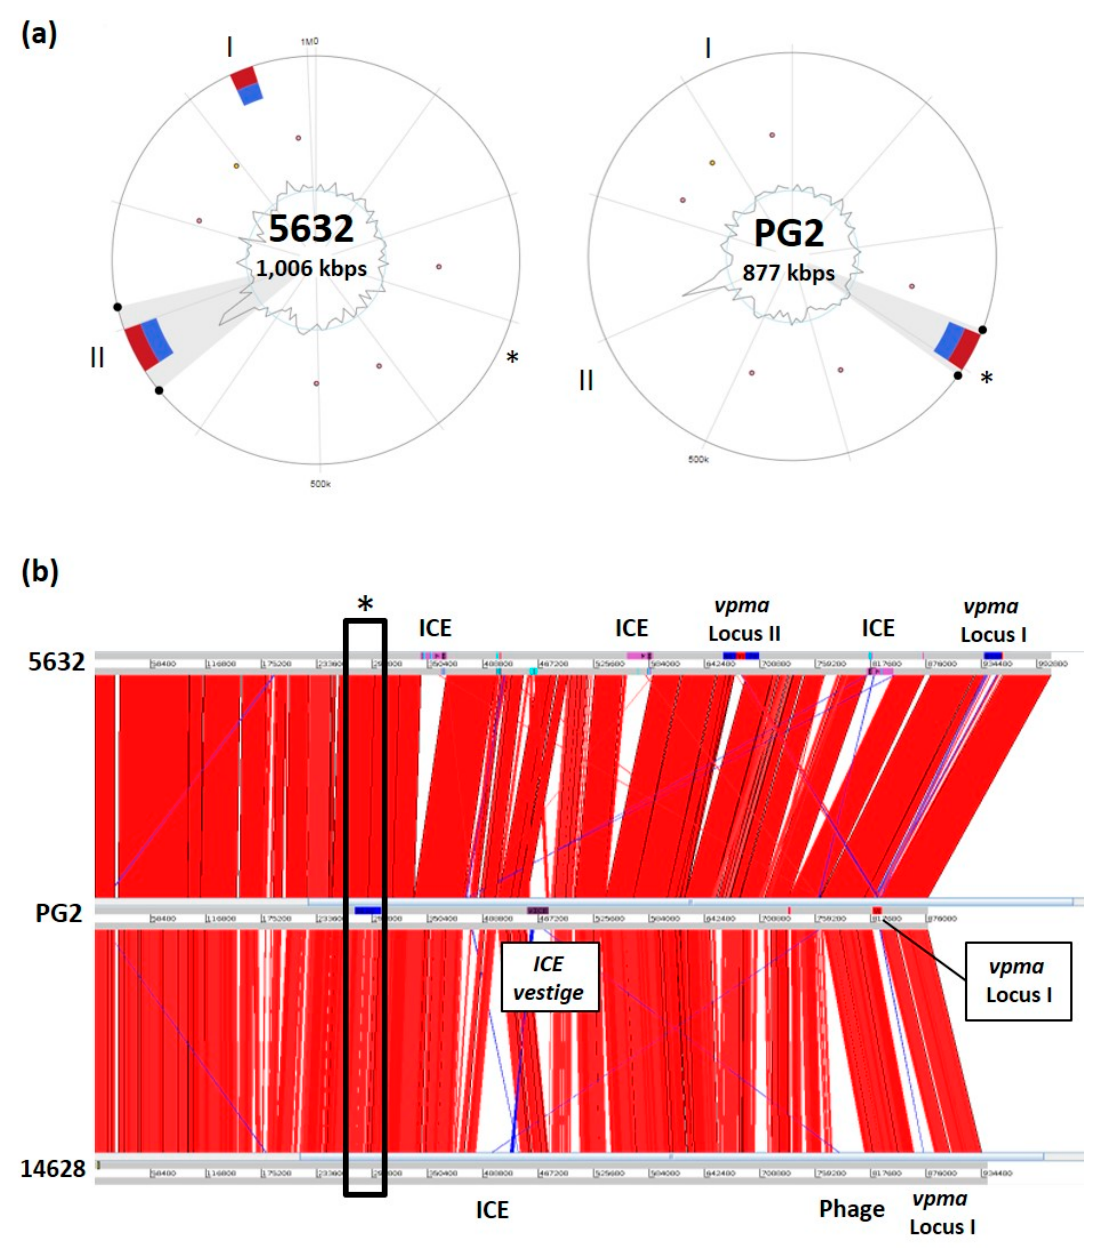
Figure 1. Genomic island (GIs) predictions and locations in three sequenced M. agalactiae strains. ( a ) GI predictions using Island Viewer 4 and the two circular genomes of M. agalactiae strain 5632 (left) and type strain PG2 T (right). The circle represents a single chromosome, with the outermost red bars indicating locations of all predicted GIs by integrating the four detection methods included in IslandViewer 4. Within the circle, GIs predictions by the software IslandPath-DIMOB are shown as blue. SIGI-HMM, IslandPick, and Islander did not give any result. Homologs to microbial resistance genes and pathogen-associated genes are indicated as circular glyphs inside the circles. ( b ) Genome comparison using the Artemis Comparison Tool and the M. agalactiae genome from 3 strains, 5632 (NCBI RefSeq NC_013948.1), PG2 (NCBI RefSeq NC_009497.1), and 14628 (WGS SPQY01000001: SPQY01000015). The vpma loci are labeled I and II and are detailed in Figure 2; the asterisk designates